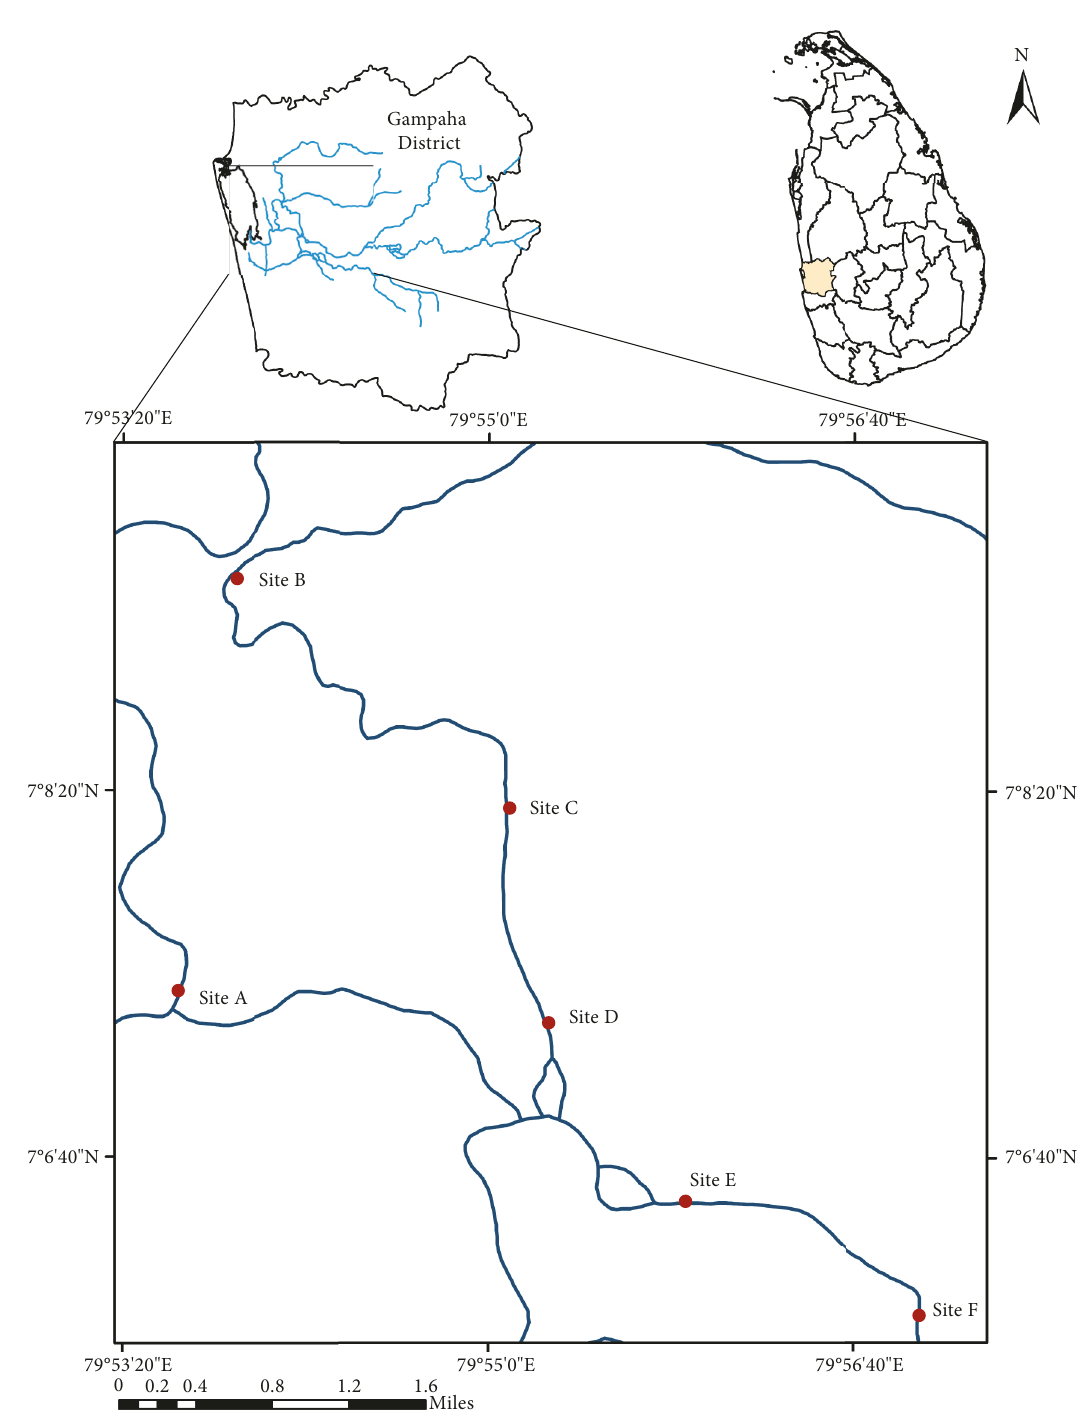
Figure 1: Map of the study area showing sampling sites (Site A: Urban; Site B: Industrial; Site C: Water intake for public water supply; Site D: Industrial; Site E: Agricultural; Site F: Reference